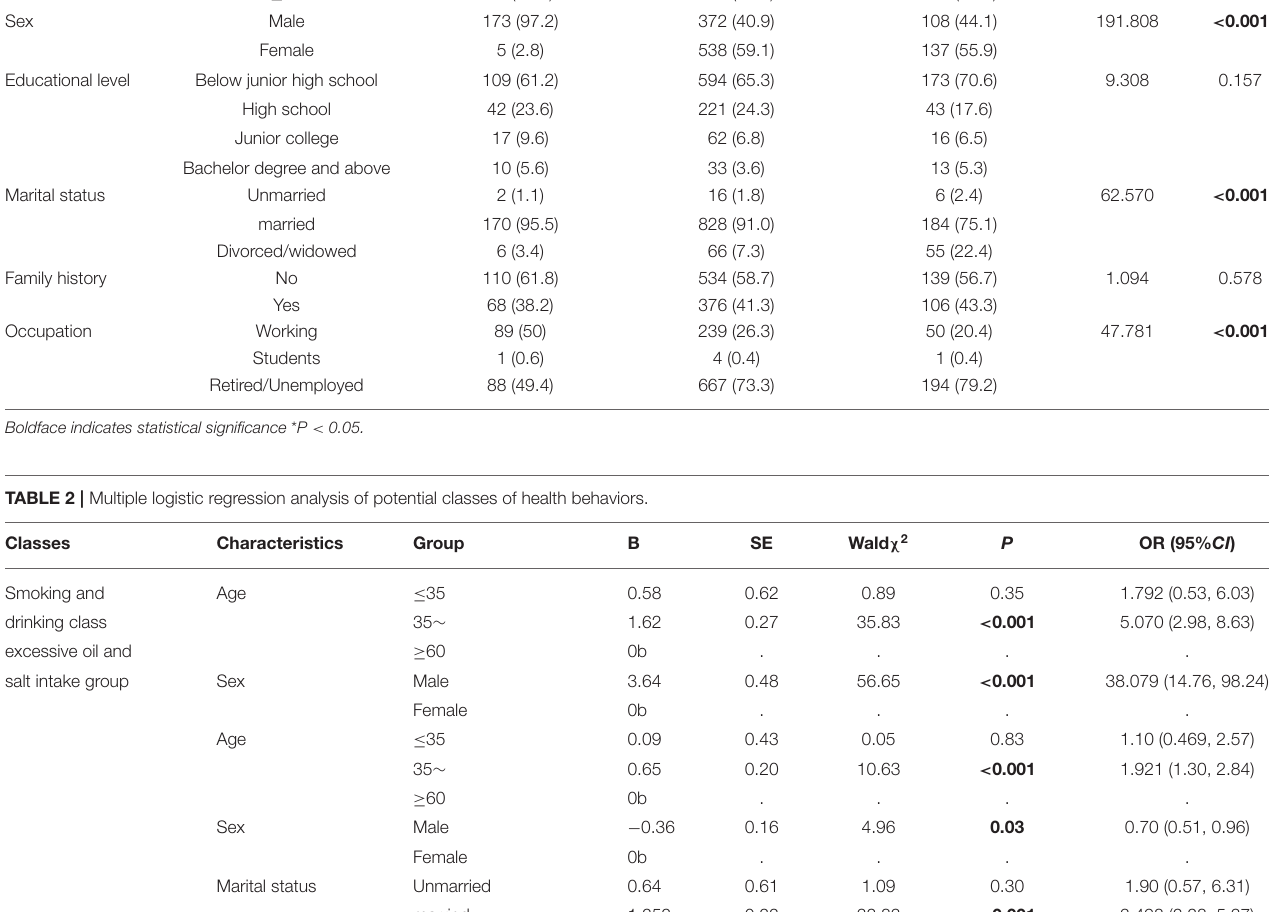
Boldface indicates statistical significance * P <